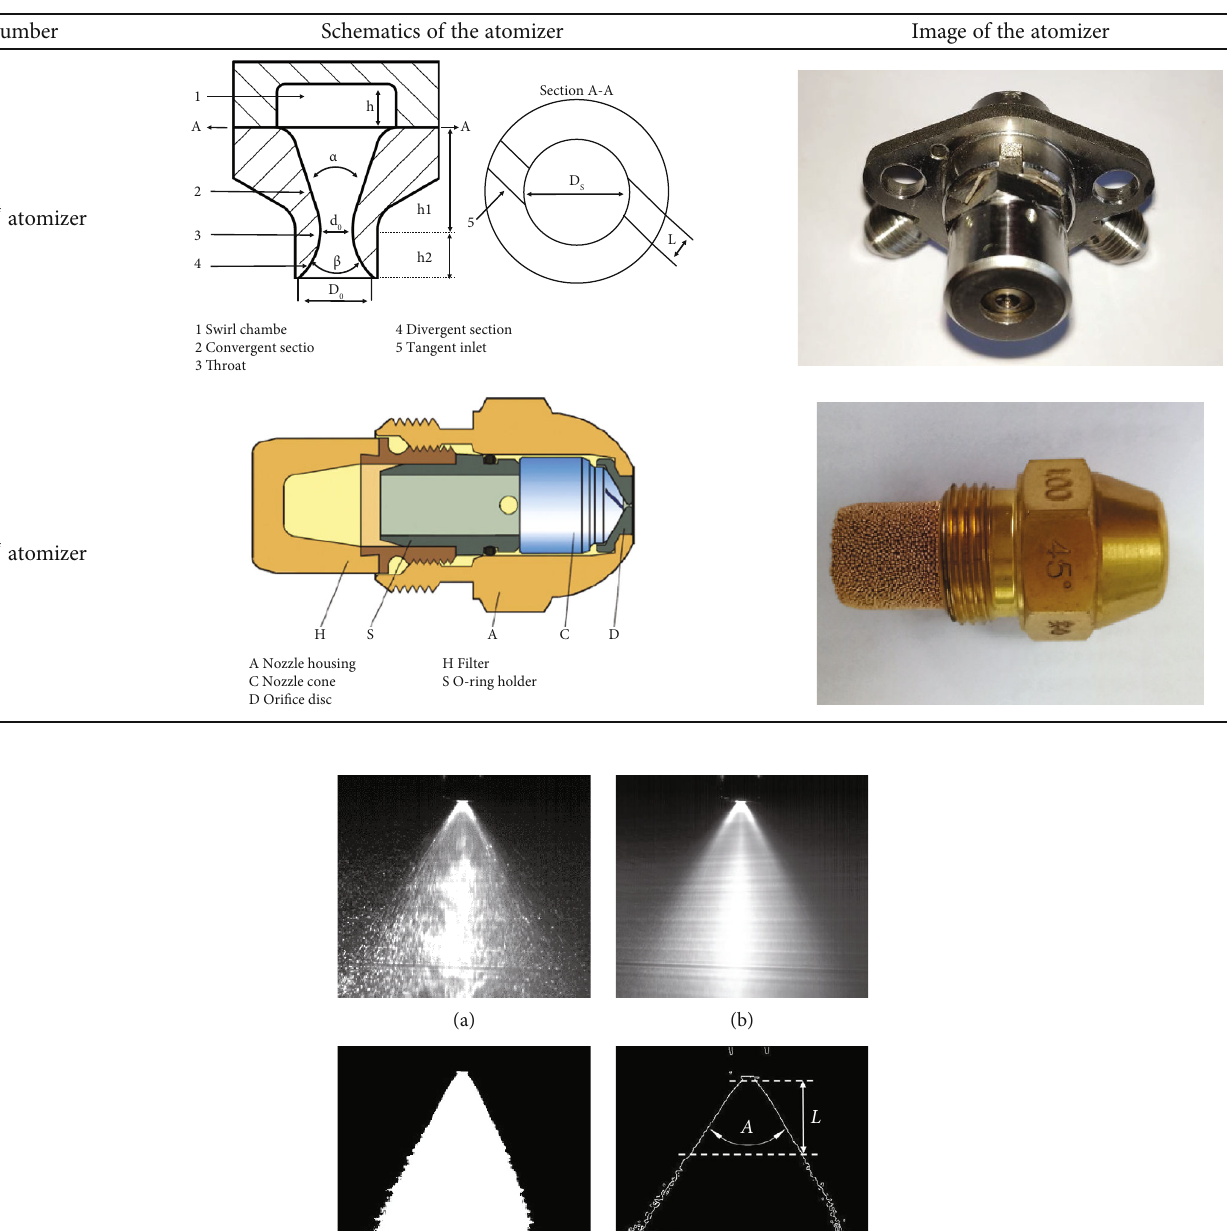
Table 3: The schematic and images of atomizers.